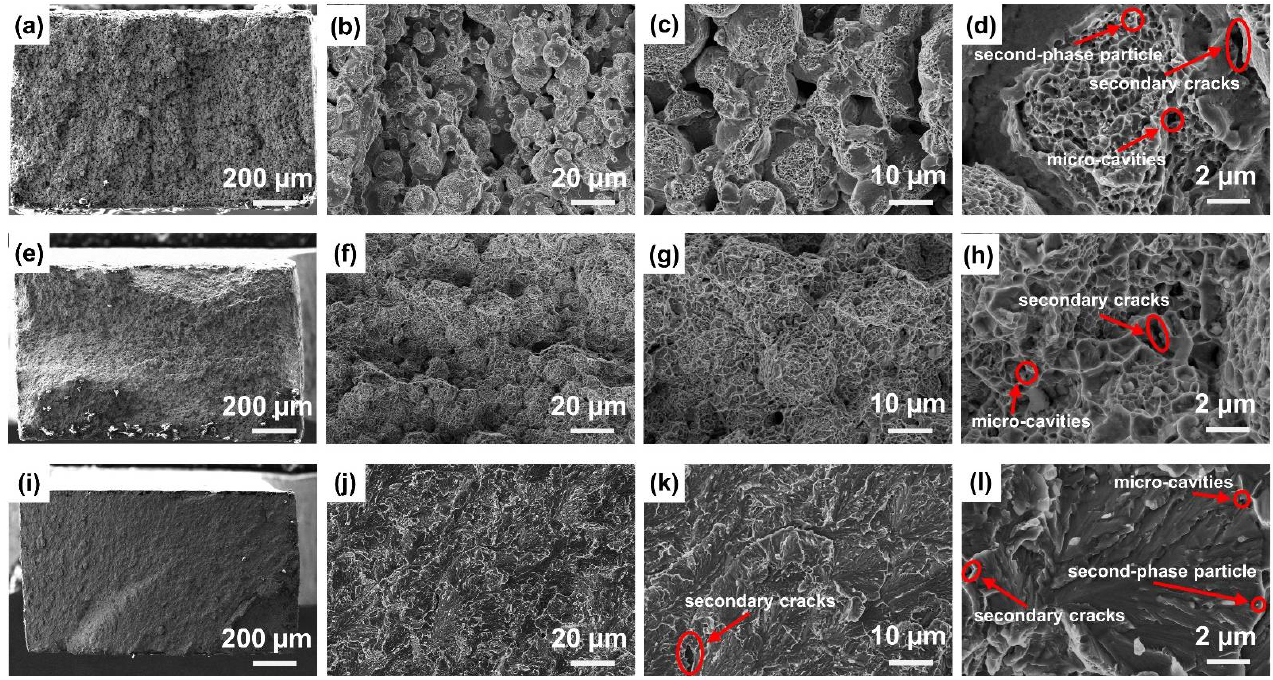
Figure 6. Tensile fractographs of ( a – d ) Al0.2 HEA; ( e – h ) Al0.5 HEA; and ( i – l ) Al1 HEA.